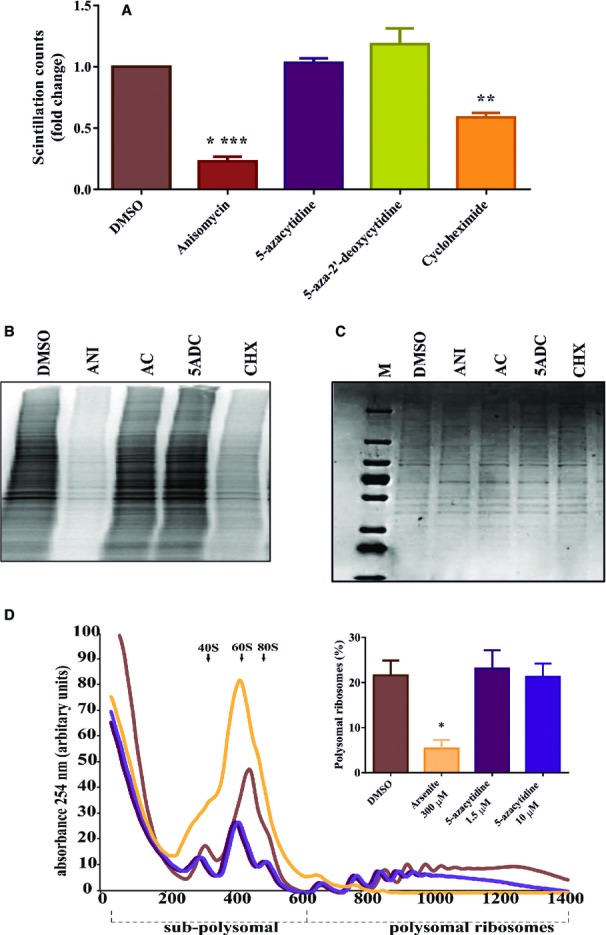
5-azacytidine does not affect de novo protein synthesis at concentrations
that inhibit NMDAnalysis of 35S-Met incorporation in HeLa cells following treatment with DMSO,
5-azacytidine, anisomycin, 5-aza-2′-deoxycytidine or cycloheximide. HeLa cells were incubated
with the compounds for 18 h, and a pulse of 35S-methionine was given for
2 h. 35S-Met incorporation was assayed by scintillation counting. One-way ANOVA
followed by Holm–Sidak multiple comparisons test was performed to analyze the significance,
N = 3 and
****P < 0.0001 for anisomycin and
**P = 0.0015 for cycloheximide. Each bar
represents average ± SD.Autoradiography of a polyacrylamide gel containing the lysates of the cells used for the analysis
shown in panel (A) (ANI = anisomycin; AC = 5-azacytidine;
5ADC = 5-aza-2′-deoxycytidine,
CHX = cycloheximide).Coomassie staining of the gel shown in panel (B) to control for equal loading.Polysomal profiles were recorded from HeLa cells treated either with the negative control DMSO or
with the positive control arsenite, or 1.56 and 10 μM of 5-azacytidine for
18 h. To determine the percentage of polysomal ribosomes, the area below the polysomal part
of the curve was divided by the area below the subpolysomal and polysomal parts of the curve and
represented as average ± SD in the bar graph. One-way ANOVA followed by
Holm–Sidak multiple comparisons test was performed to analyze the significance,
N = 3 and
*P = 0.03 for arsenite treatment.Source data are available online for this figure.